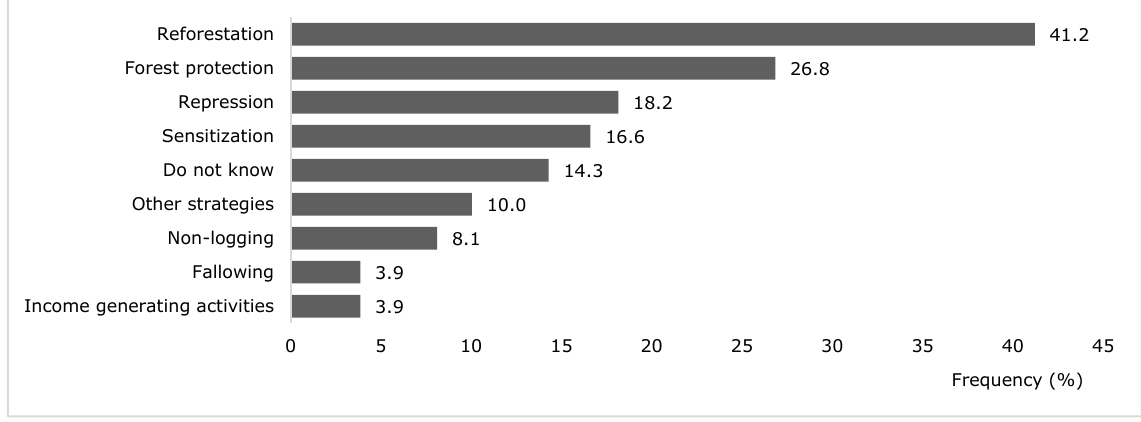
Figure 8. Perceptions of main strategies against deforestation in the community of south-western Côte d’Ivoire.